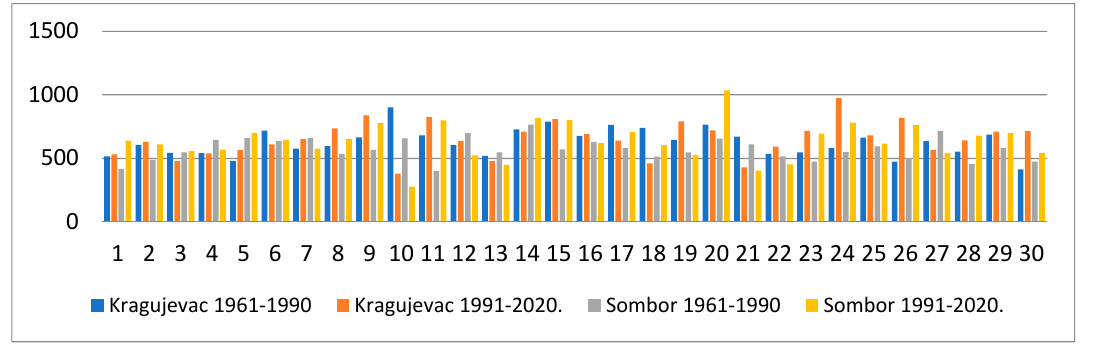
Figure 4. Amount of precipitation per year in Kragujevac and Sombor for the periods 1961–1990